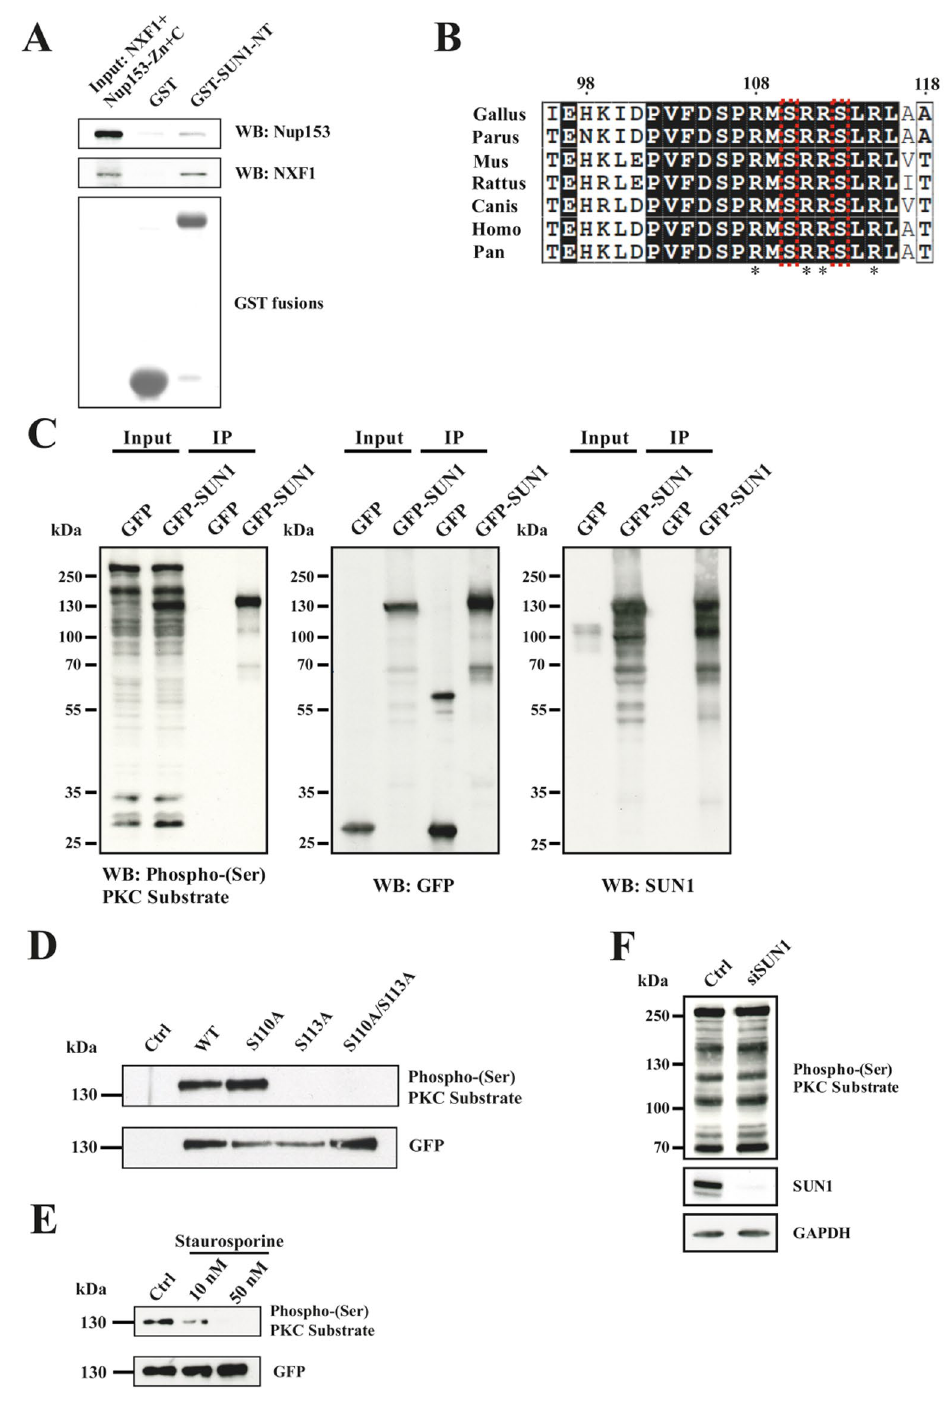
Figure 1. SUN1 interacts differentially with NUP153 and NXF1 and is a substrate of protein kinase C. ( A ) Competition between NXF1 and NUP153 for SUN1 binding. Recombinant NXF1/NXT and Nup153-Zn + C released from GST (input) were used for pull down experiments with GST (control) and GST-SUN1-NT. NXF1 and NUP153 were detected by antibodies. Below the pull down a western blot detecting the GST proteins is shown. ( B ) Comparison of the highly conserved predicted PKC phosphorylation site in SUN proteins from various species. The numbering corresponds to human SUN1 (ACCESSION: EAL23707). The S residues S110 and S113 are boxed in red. Stars point out the consensus sequence. Boxed in black, identical amino acid residues, boxed in white, similar amino acid residues. ( C ) Cell lysates from GFP and GFP-SUN1 expressing HeLa cells (Input) were used for pull downs using GFP trap beads (IP) and probed with Phospho-(Ser) PKC Substrate, GFP and SUN1 antibodies as indicated. ( D ) WT SUN1 and SUN1 proteins carrying point mutations at the indicated positions were expressed as GFP fusions in HeLa cells and precipitated using GFP trap beads. The blot was probed with Phospho-(Ser) PKC Substrate and GFP antibodies. For control, cells